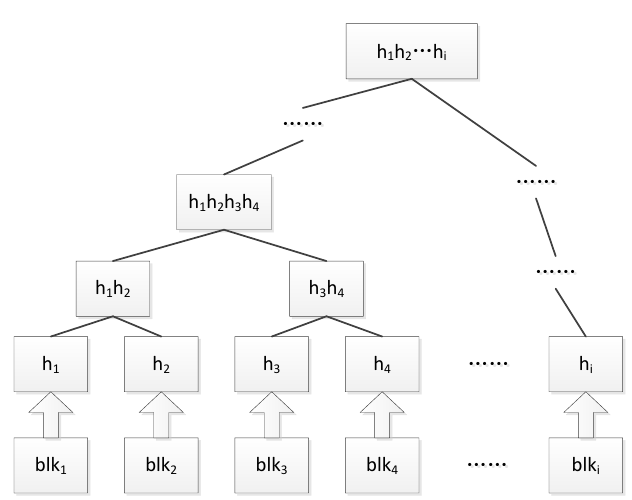
Figure 3. The storage structure that can be used by a prover to reduce its computational complexity when generating